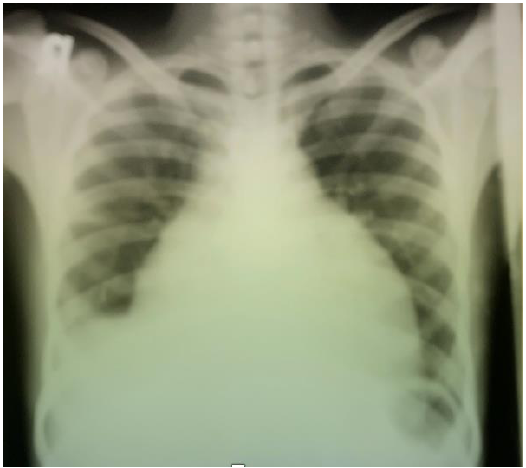
Figure 1. Chest X-ray postero-anterior view showing massive cardiomegaly due to pericardial effu-